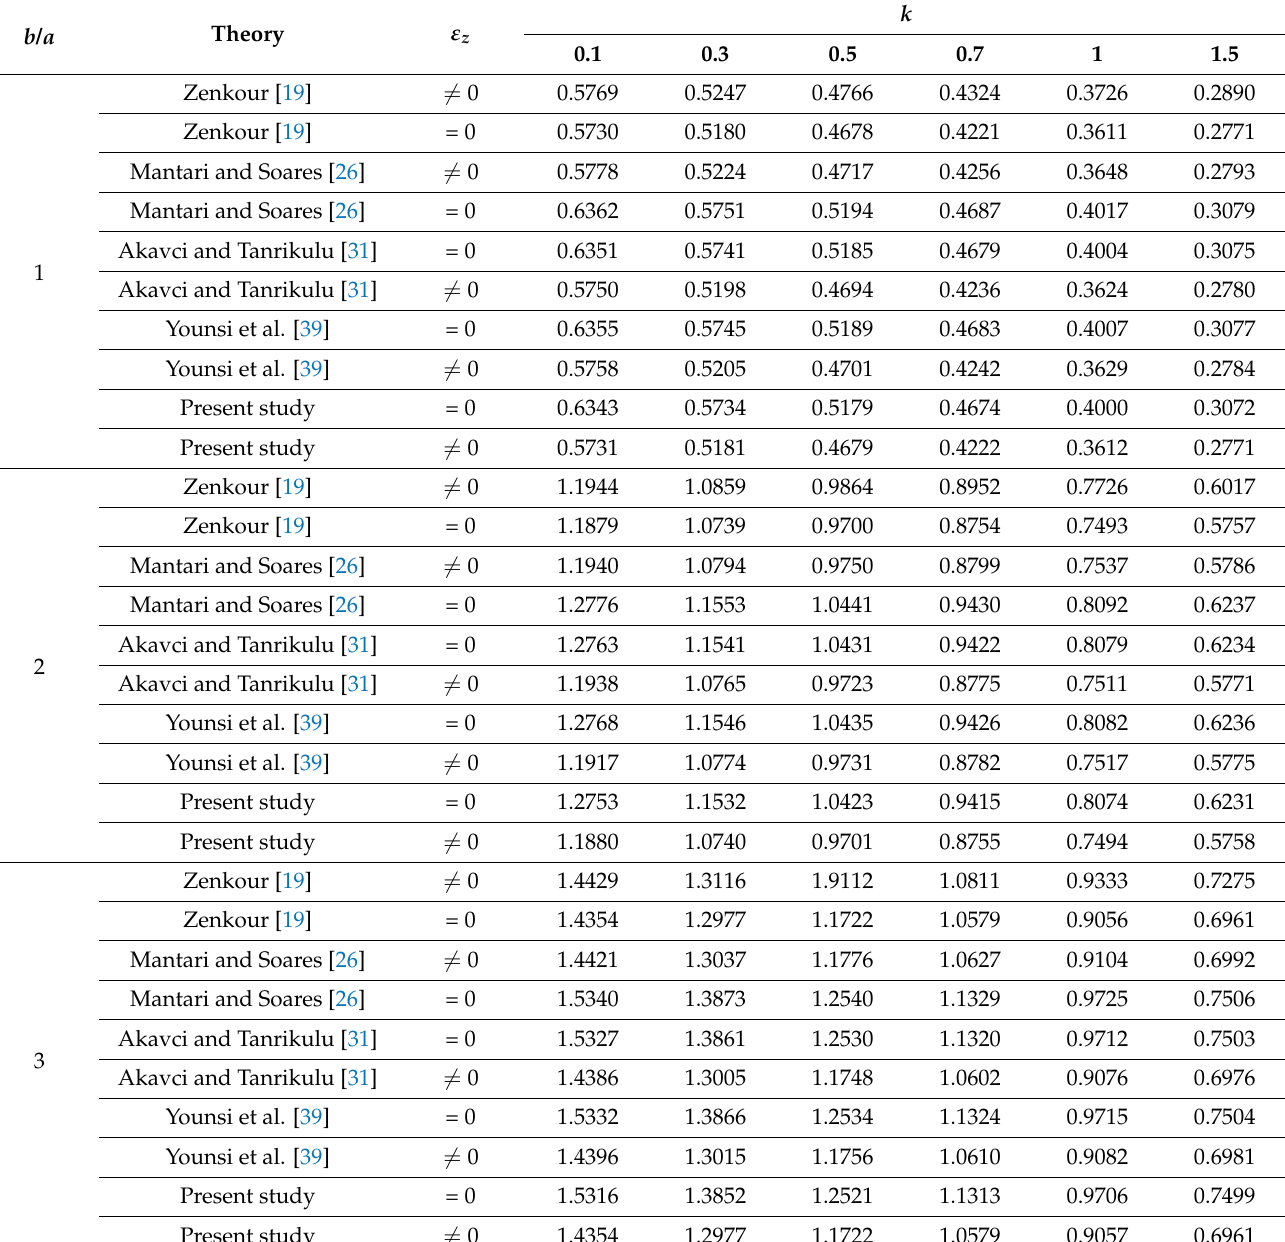
Table 4. Non-dimensional deflection w ( 0 ) = 10 h 3 E 0 distributed load ( a / h =